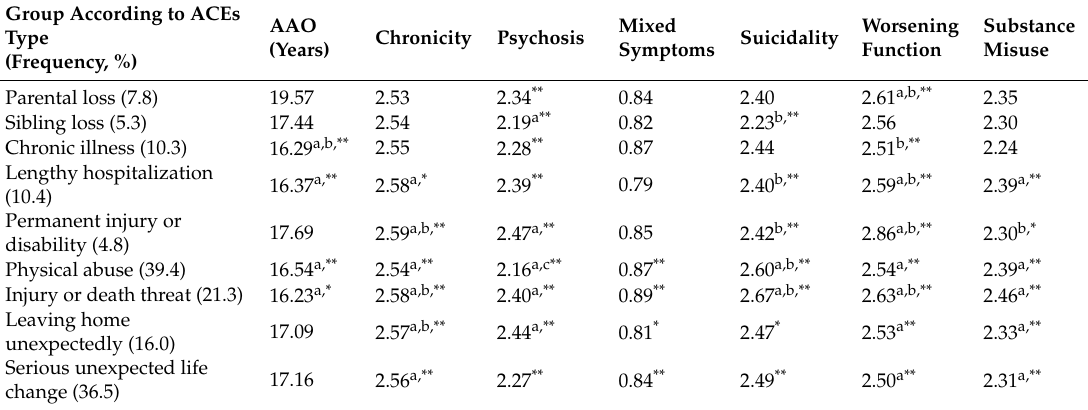
Table 6. Age at onset and scores of the Diagnostic Interview for Genetic Studies of clinical outcomes in the group with adverse childhood experience compared to groups with adverse post-childhood experience and without adverse experience.